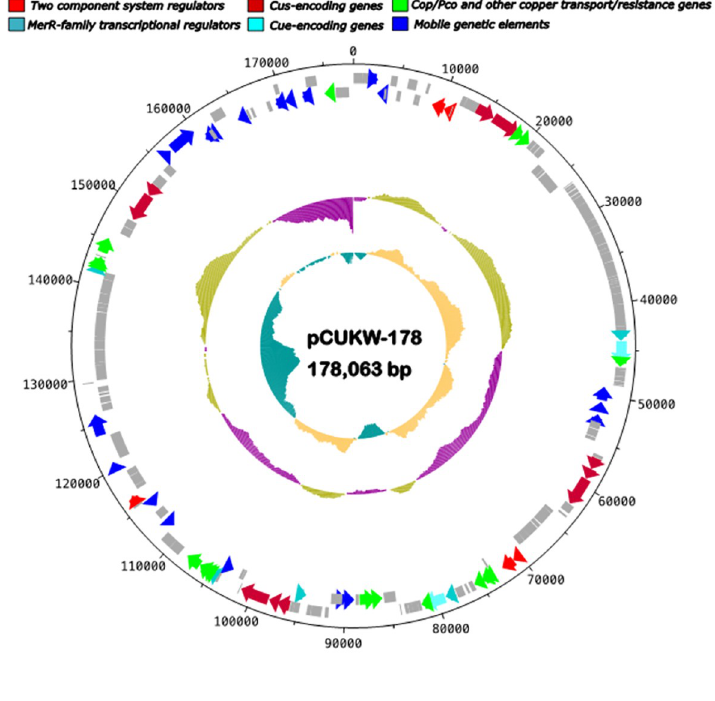
Fig 9. Genetic map of plasmid pCUKW-178. The rings (outer to inner) indicate CDSs on forward and reverse strand (ring 1 and ring 2), GC plot (ring 3), GC skew (ring 4). The CDSs are color coded as follows: mobile genetic element (dark blue), two component system regulators (red), MerR-family transcriptional regulator (dark aqua), Cus-encoding genes (dark red), Cue-encoding genes (aqua), Cop/Pco and other copper transport/resistance genes (bright green). The value of the GC plot is shown as: green for G+C content above average level and violet for G+C content below average level. The value of GC skew shows over abundance in yellow and under abundance in blue.